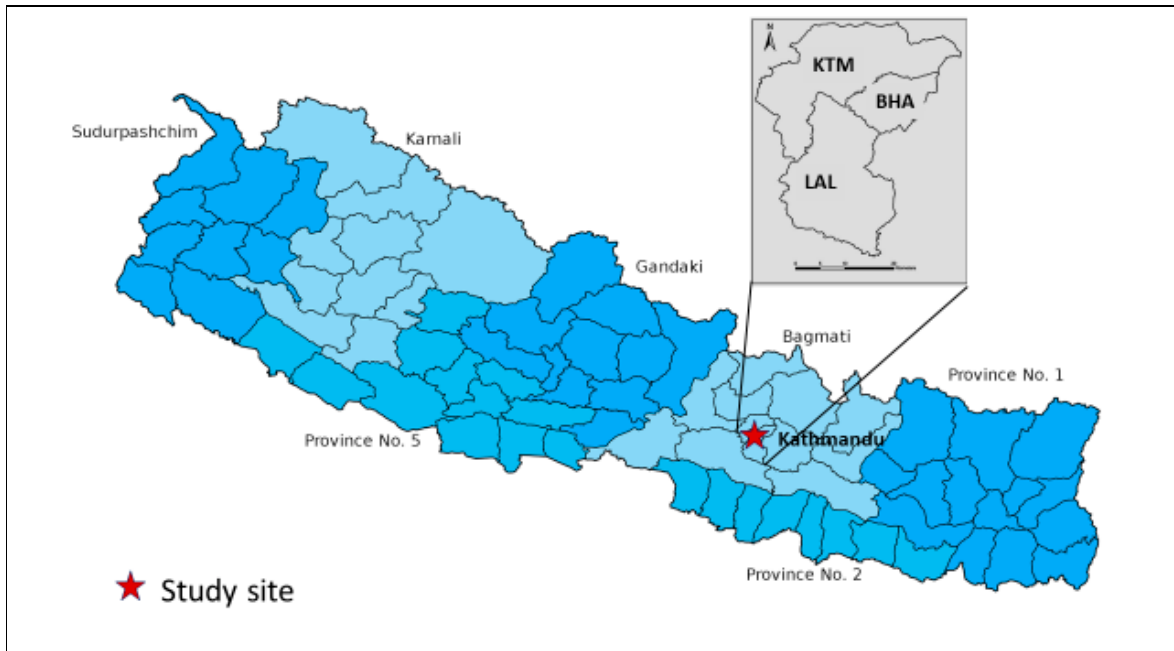
Figure 1. Map of Nepal showing the study